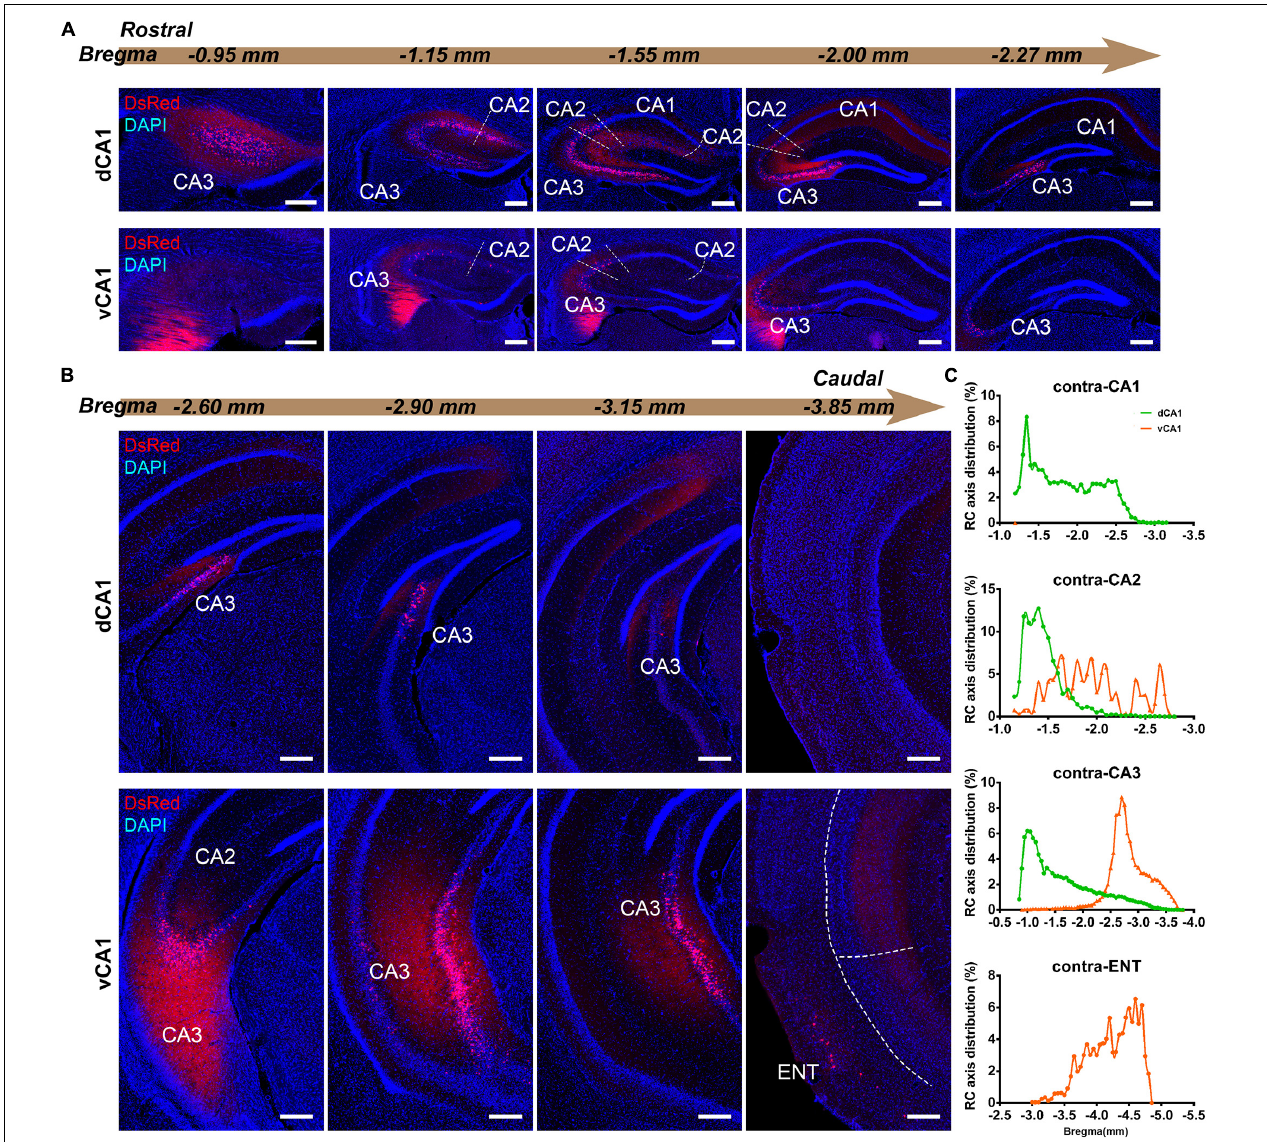
FIGURE 4 | Inputs to CA1 PNs from contralateral HIP subregions. (A,B) Representative images showing distributions of the input neurons located in contralateral HIP. Scale bar: 250 µ m. (C) Distribution patterns of the input neurons along the RC axis in different subregions of the contralateral HIP. In the contralateral HIP, the input neurons were found located in the CA1, CA2, and CA3 for the dorsal CA1 tracing group and in the CA1, CA2, CA3, and ENT for the ventral CA1 tracing